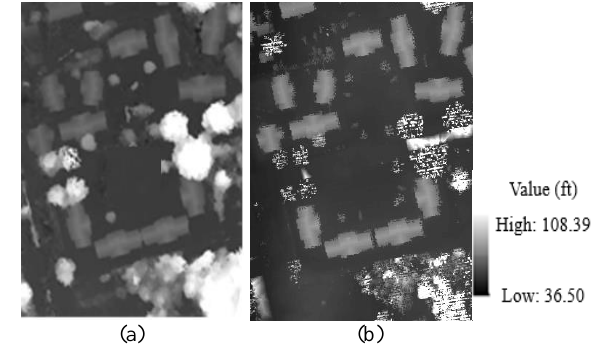
Figure 4. (a) UAV-based DSM (b) Lidar-based DSM